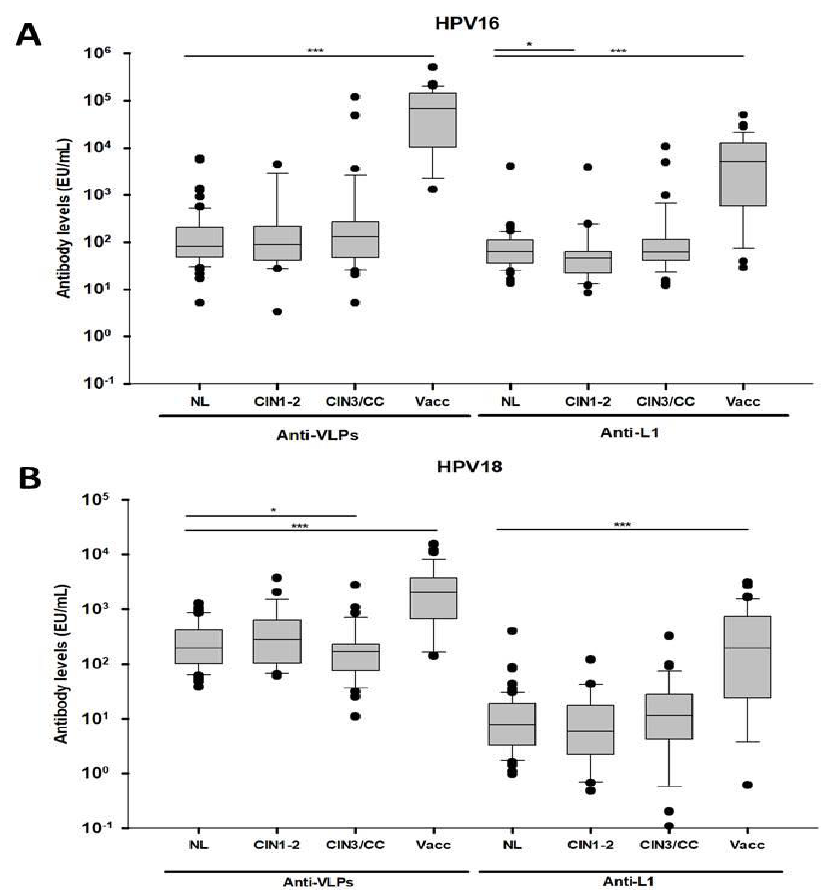
Figure 1. Antibody response against VLPs and L1 from HPV16 and HPV18. The distributions of the antibody levels (EU/mL) obtained from the VLPs and L1 from HPV16 ( A ) and HPV18 ( B ) by ELISA were plotted for each group studied and represented as data scatter boxes. The EUs for all the samples were adjusted for the dilution factor (dil 1:100). NL, no lesion; CIN1-2, cervical intraepithelial neoplasia 1 – 2; CIN3/CC, cervical cancer; Vacc, vaccinated women. Statistical significance * p < 0.05 and *** p < 0.0001 .